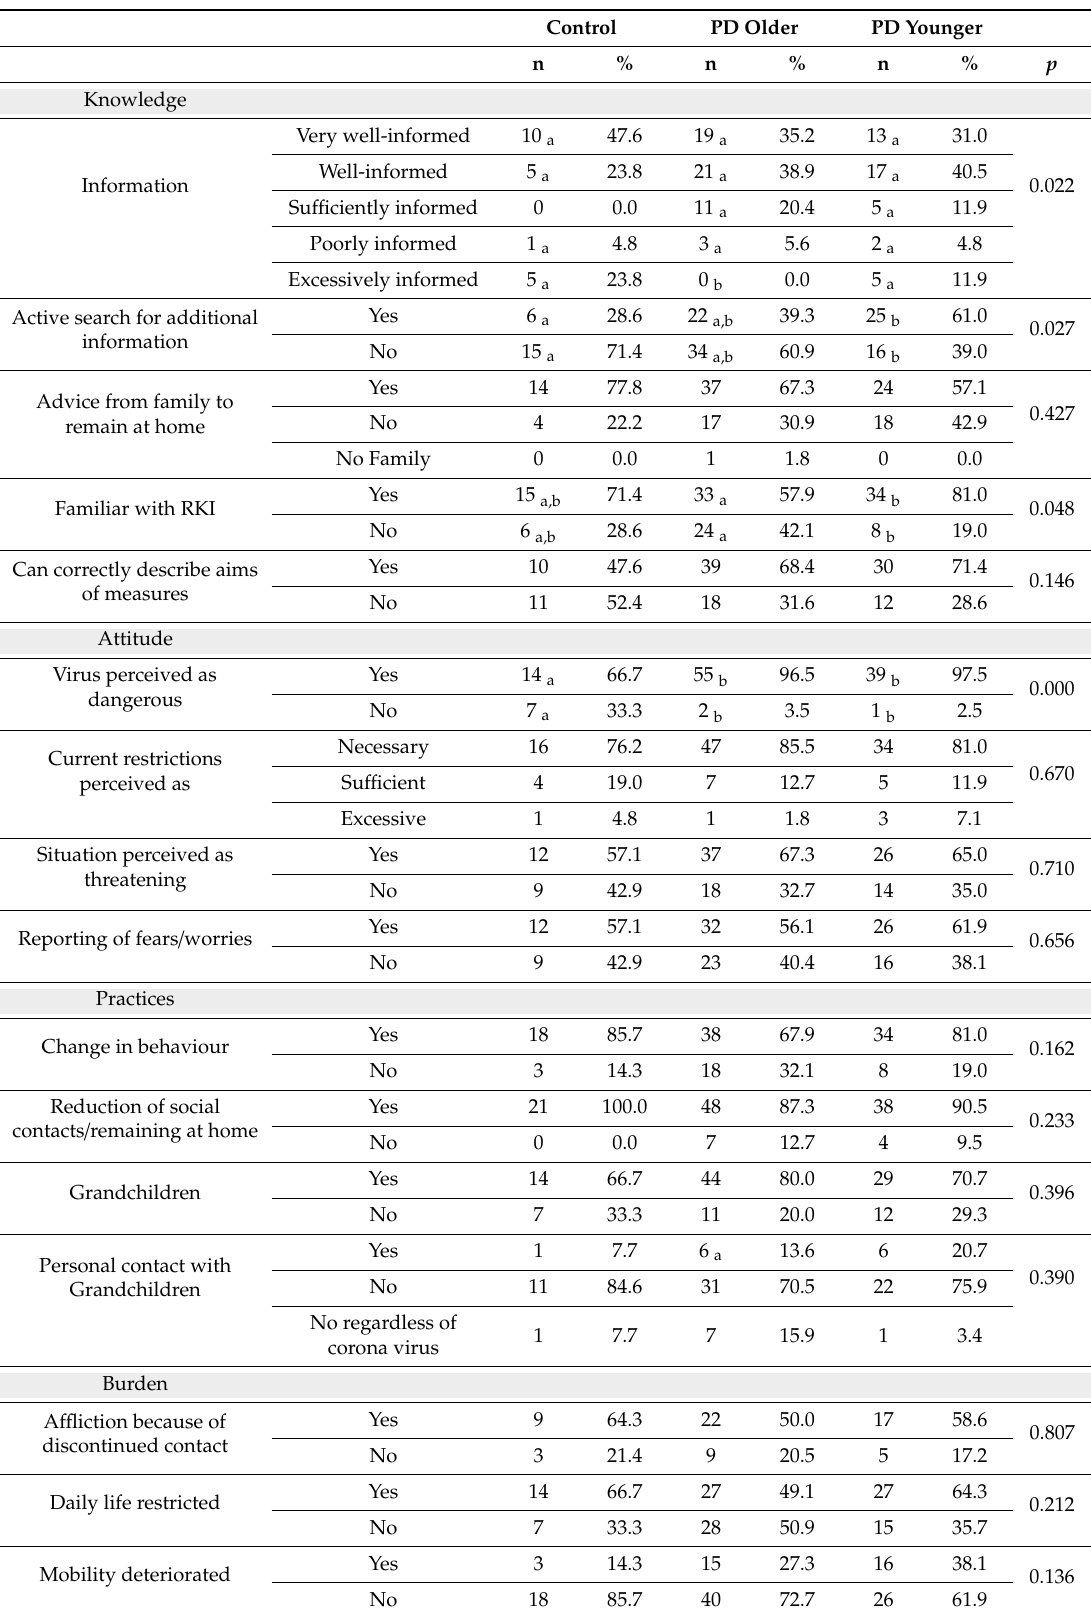
Table 2. Group comparisons KAP and